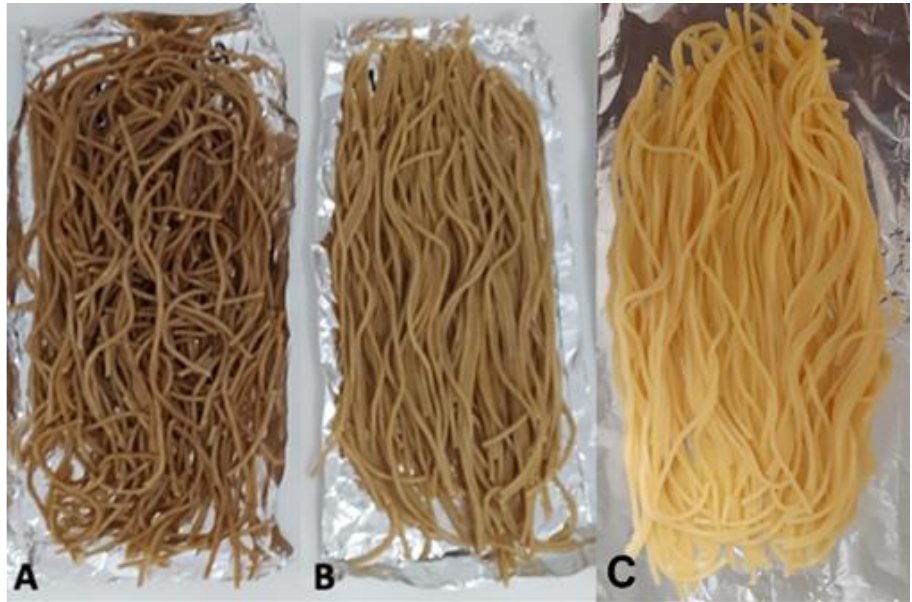
Figure 1. Wholegrain einkorn, namely cv Hammurabi ( A ) and cv Norberto ( B ), and semolina ( C ) cooked spaghetti.